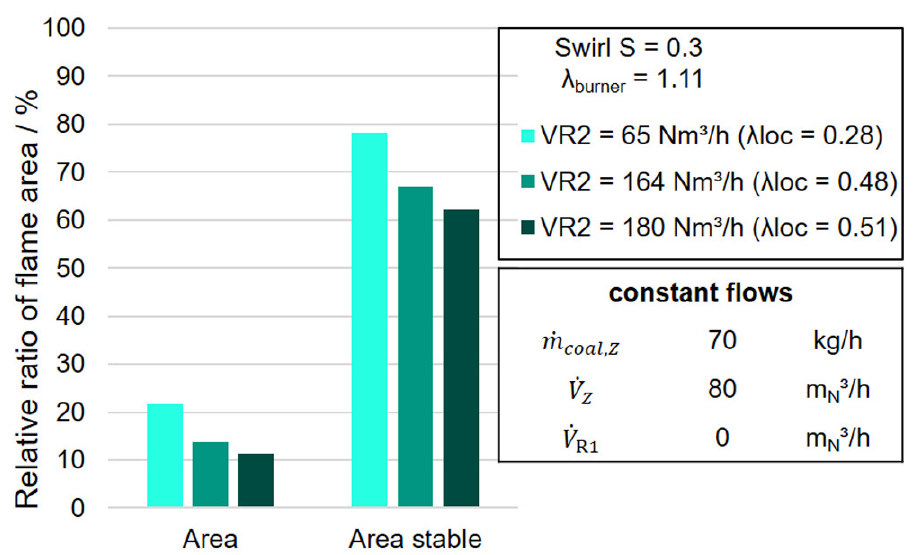
Figure 12. Image analysis of relative flame area.